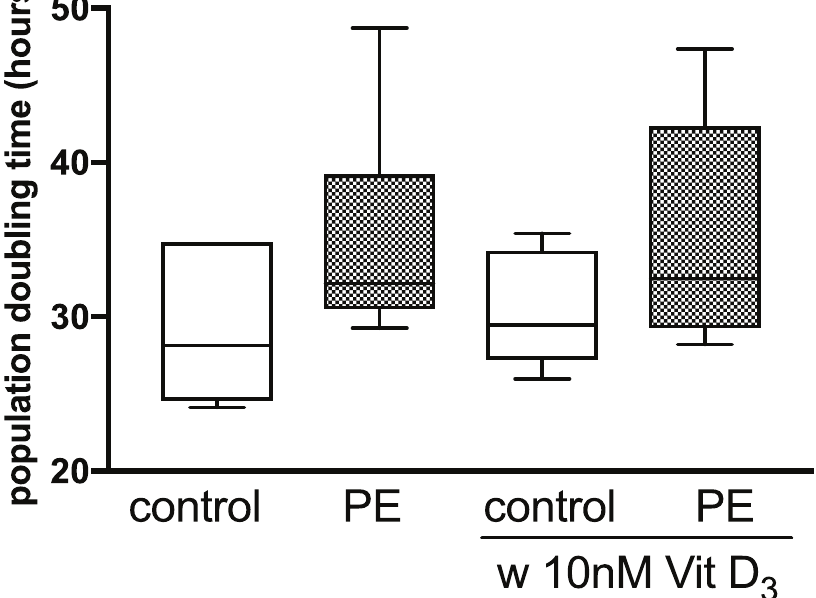
Fig 4. Effect of pregnancy outcome and 1,25(OH) 2 vitamin D 3 on HUVEC population doubling time. HUVEC of uncomplicated (control) and preeclamptic (PE) pregnancies were incubatedin the presenceand absenceof 1,25(OH) 2 vitamin D 3 (10 nM). Cell numbers were counted and populationdoublingtime calculatedafter 72 h. The ends of the whiskers represent the maximum and minimum